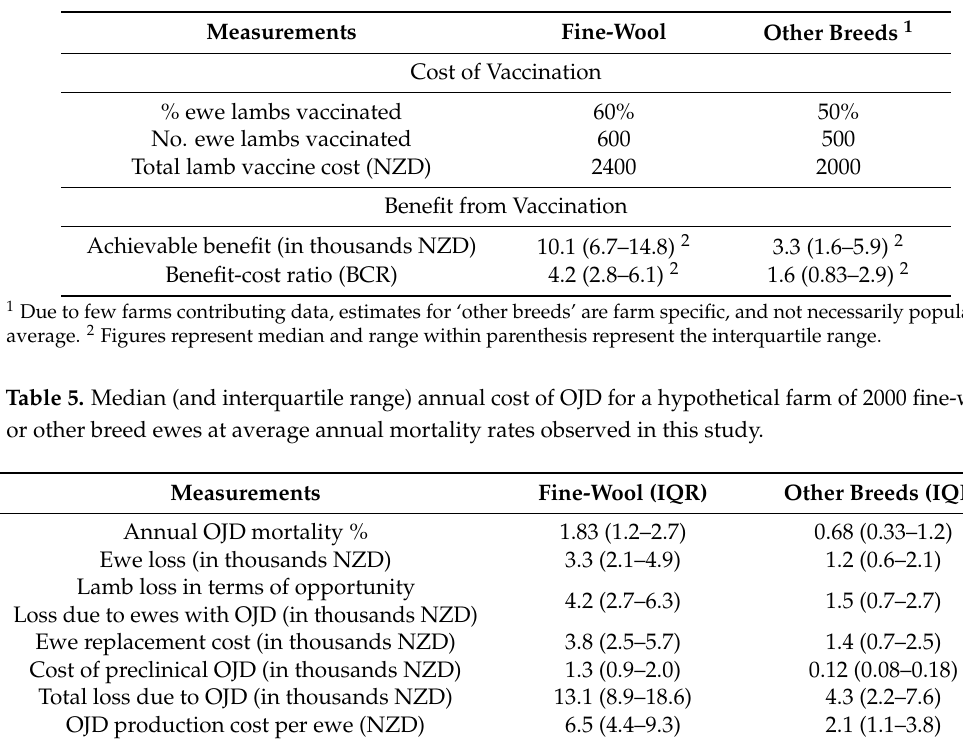
Table 4. Stochastic analysis, and assumptions used, for estimation of benefit-cost of vaccination of lambs in a hypothetical fine-wool and other breed flock of 2000 ewes, based on calculated mortality rates from this study and 90% vaccine efficacy for reducing mortality.